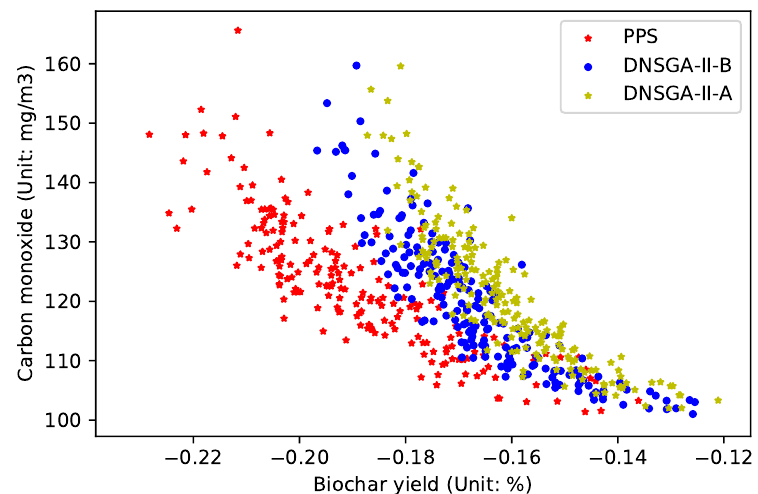
Figure 5. Obtained POF of three algorithms with τ t = 30.